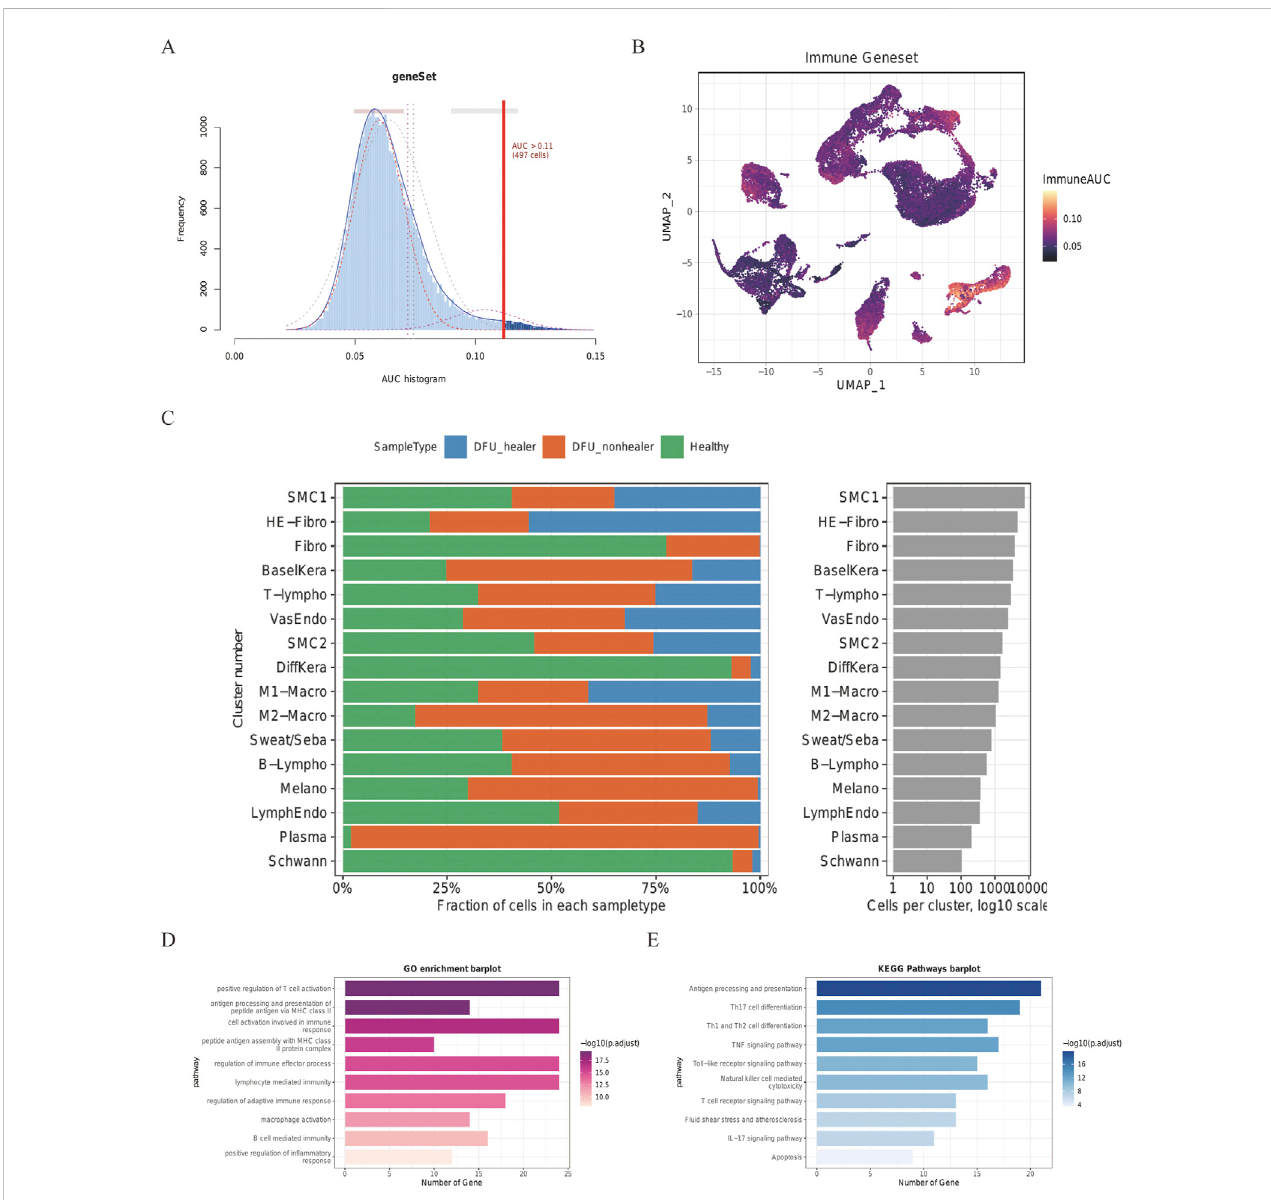
FIGURE 3 Skin cell group IRG score in DFU patients. Score from 212 screened IRGs. (A) Cutoff point was set at 11. (B) t-SNE chart showing the IRG results for every group. More genes were expressed by M1- and M2-Macro cells, which also had higher AUC values. (C) Quantity and makeup of every specimen ’ s cells. (D) DEGs in M1-Macro cluster GO assessment. (E) DEGs in M1-Macro cluster KEGG